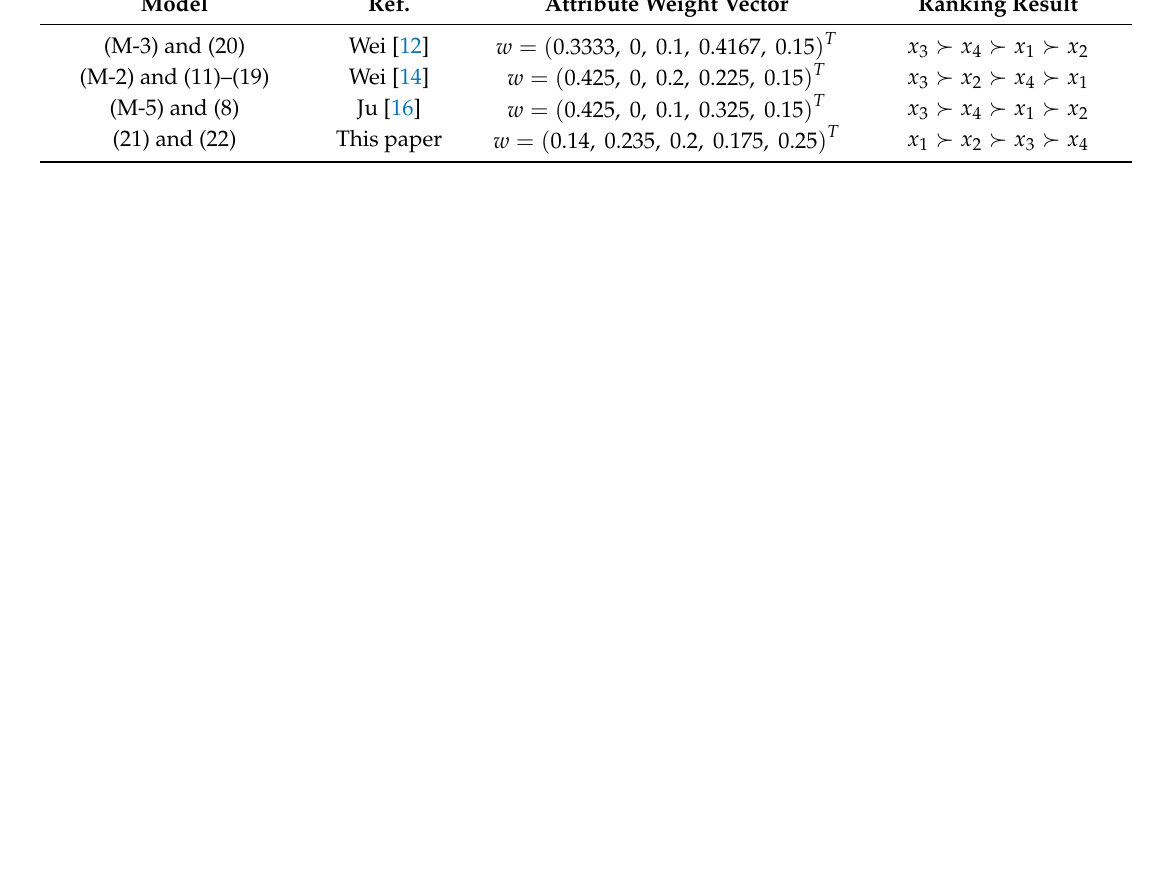
Table 7. Group triangular fuzzy decision matrix (cid:101) G =